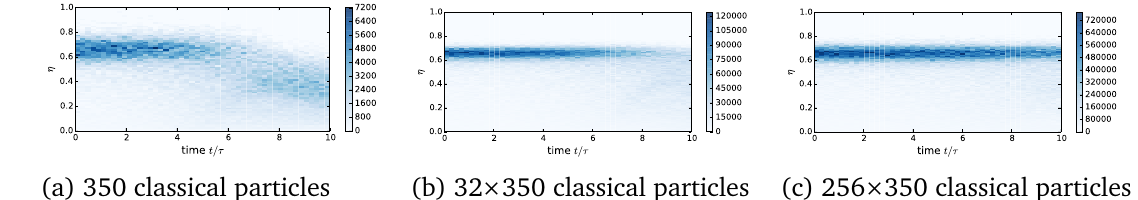
Figure 7: Time-evolution of the quantities Q ( η ) , that are exactly conserved in pure GHD, but not in microscopic realizations of GHD. We see that, as the discretization is refined, and more and more fine structures of GHD are probed by the microscopic model, the quantities are conserved on longer times. Differences of thickness be- tween the various cases are due to noise level differences.